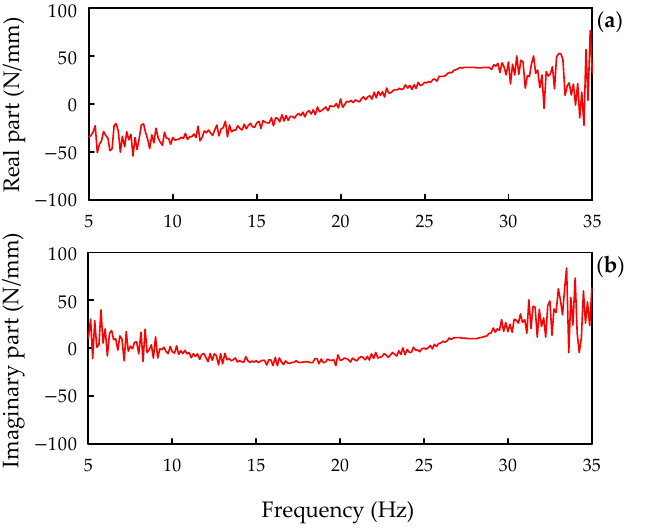
Figure 12. Dynamic stiffness for the rubber bushing of the radiator: ( a ) the real part and ( b ) the imaginary part. Table 2. Equivalent stiffnesses and damping coefficients of the bushings, hoses, and mounts at the idle frequency of 27.7 Hz.